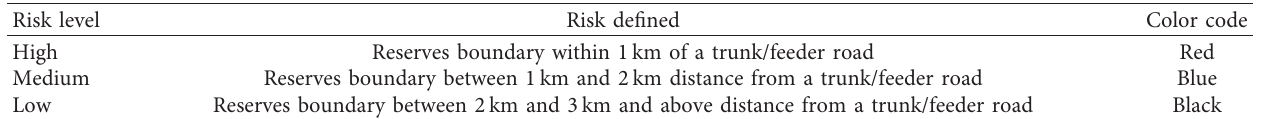
Table 8: Illegal disturbance risk level